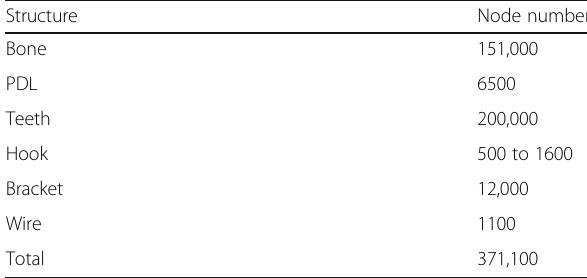
Table 3 Approximate number of